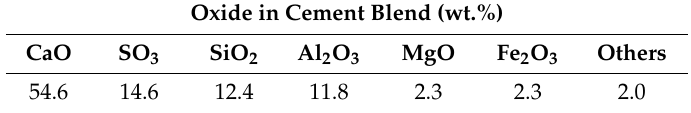
Table 2. The chemical oxide composition of the raw cement blend from X-ray fluorescence. Oxide in Cement Blend (wt.%)